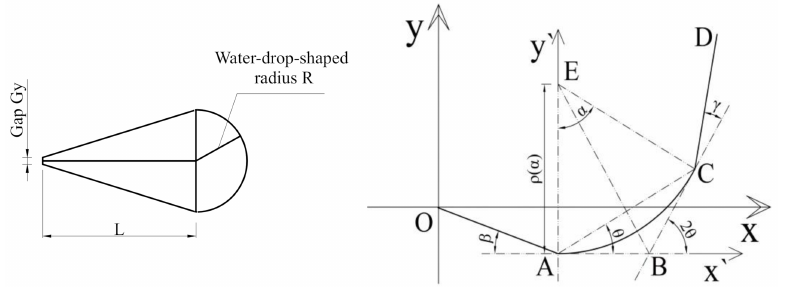
Figure 11. ( a ) Simplified water-drop geometry; ( b ) geometric relationship of the